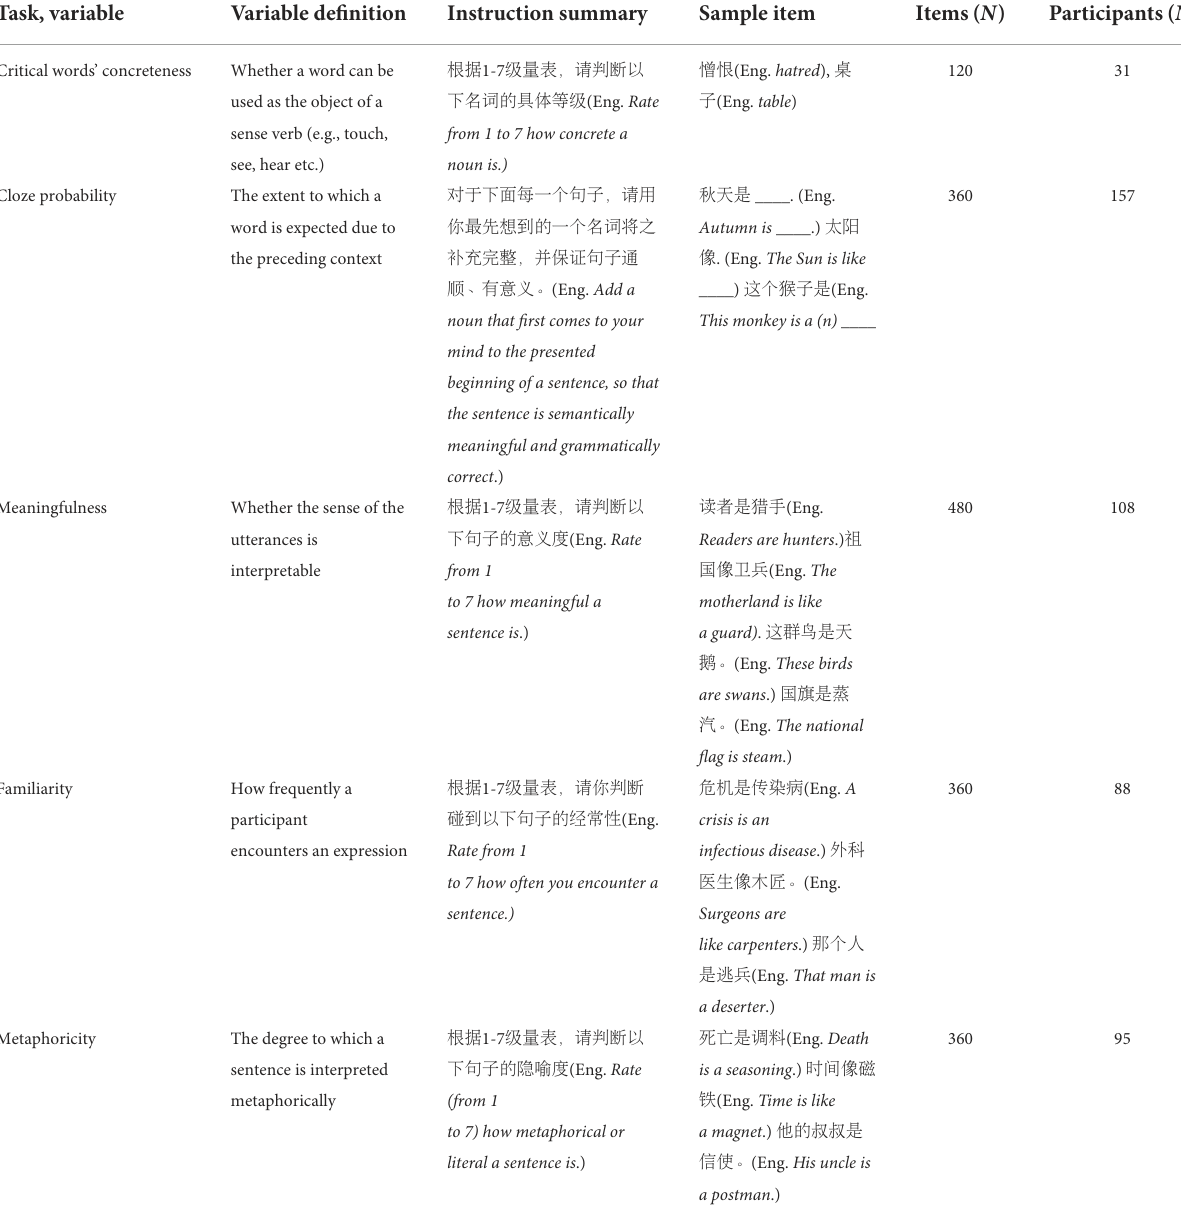
TABLE 1 Basic definitions of the variables and an overview of the rating tasks. Task,